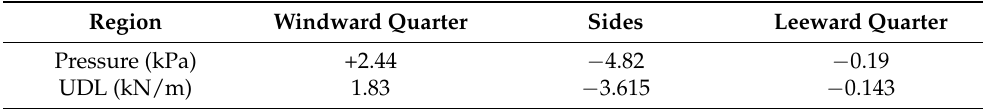
Table 2. Wind loads on the